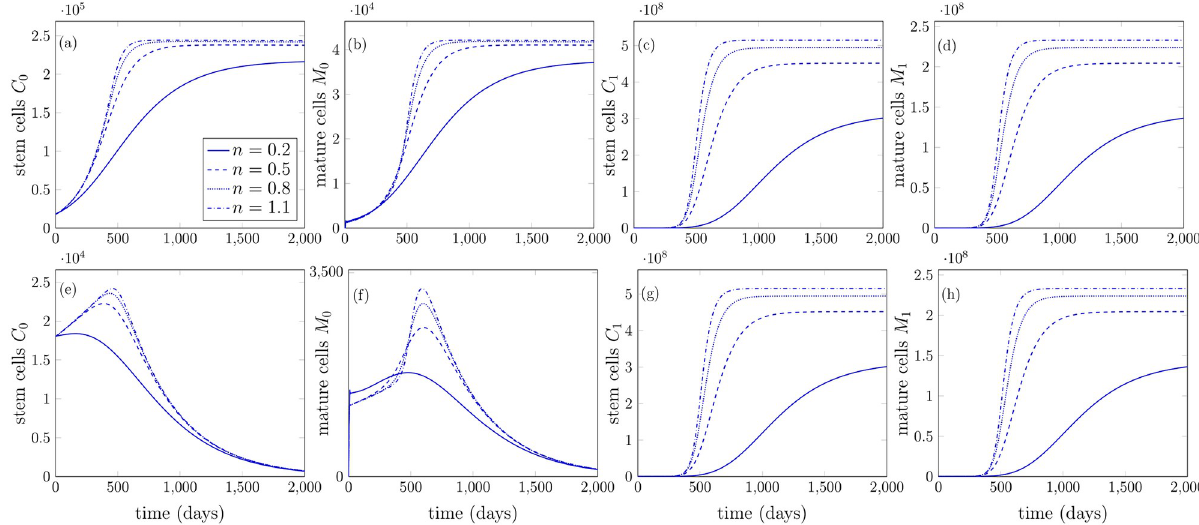
Fig 8. Model behavior by using Hill feedback function for various Hill coefficient values. (a)-(d) All cell states achieve non-trivial steady states. (e)- (h) Pure cancerous steady states where healthy cells decline with time.